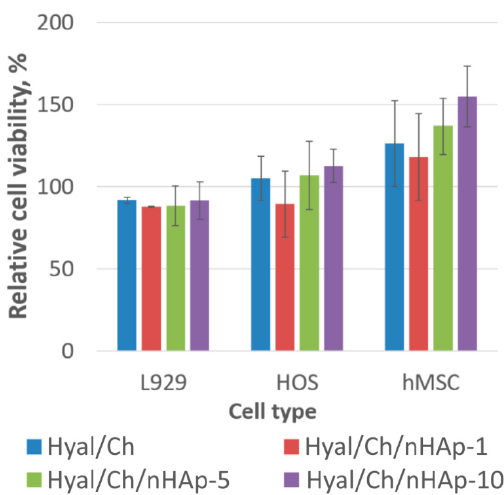
Figure 7. Viability of mouse fibroblasts L929, human osteosarcoma cells (HOS) and human mesenchymal stromal cells (hMSC) after cultivation within the hyaluronic acid/chitosan hydrogels for 1 week. The Hyal/Ch sample was without hydroxyapatite nanoparticles; the Hyal/Ch/nHAp-1, Hyal/Ch/nHAp-5 and Hyal/Ch/nHAp-10 samples were loaded with 1, 5 and 10 wt. % of hydroxyapatite nanoparticles, respectively. Results of MTT-test. The monolayer culture (without the hydrogel sample) was taken as a control (100%). Three parallel replicates were carried out for each sample.